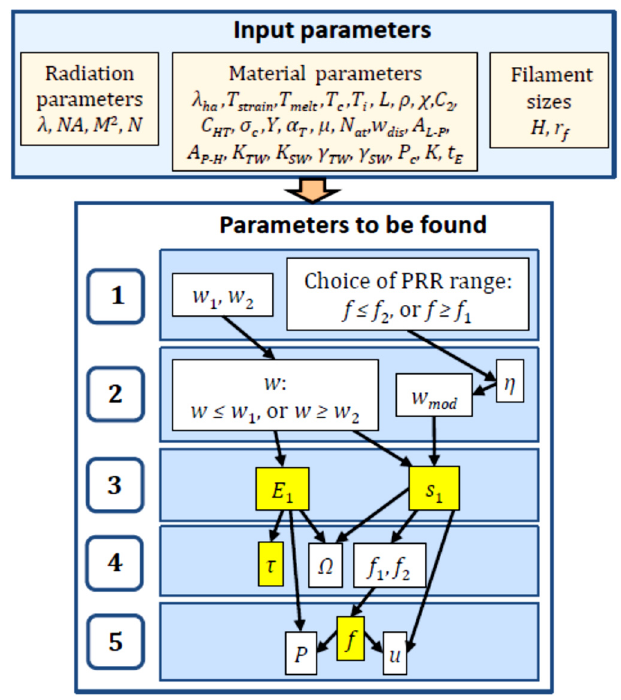
Figure 7. Schematic of the algorithm for calculating the main irradiation parameters E 1 , τ , s 1 and f (highlighted in yellow), which are preferred for the LFC with a better smoothness of separation for the heat diffusion modification mechanism. For the alternative shock-wave mechanism, the smooth separation is not achieved, but this scheme, if formally to put in it η = 0 and f 1 = f 2 , can be used in this case as well—to create a separation with filaments which are more straight and more uniform in diameter along the length. 5 consecutive stages are shown for calculation of unknowns E 1 , τ , s 1 and f .